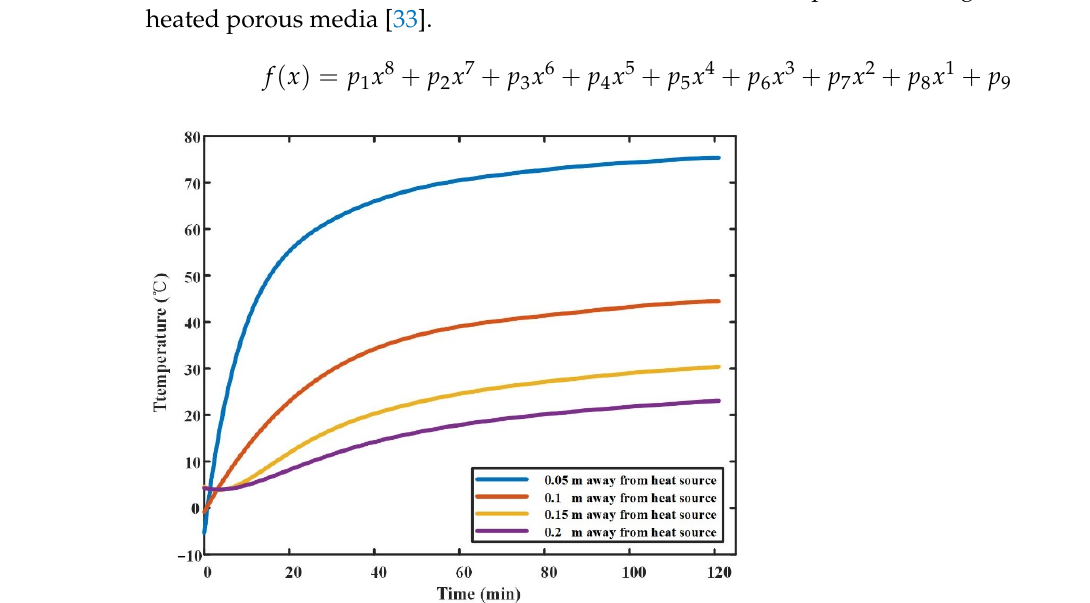
10 of 17 Figure 8. Table of the surface of the probe temperature: ( a ) simulation with heating time of 1200 s;